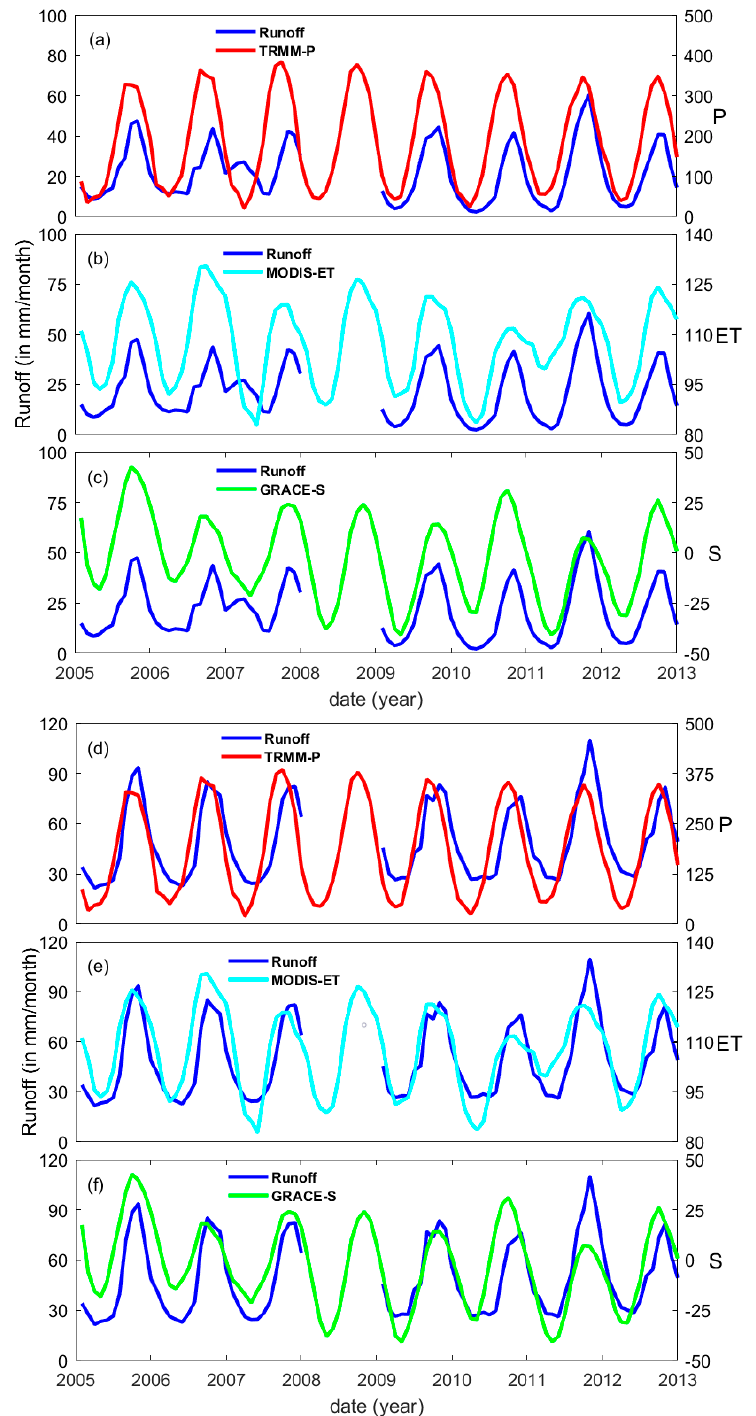
Figure 4. The time series of runoff against remotely-sensed hydrological variables. At My Thuan: ( a ) Tropical Rainfall Measuring Mission precipitation ( TRMM-P), ( b ) Moderate Resolution Imaging Spectrometer evapotranspiration ( MODIS-ET), and ( c ) Gravity Recovery and Climate Experiment terrestrial water storage (GRACE-S) values. At Tan Chau: ( d ) TRMM-P, ( e ) MODIS-ET, and ( f ) GRACE-S